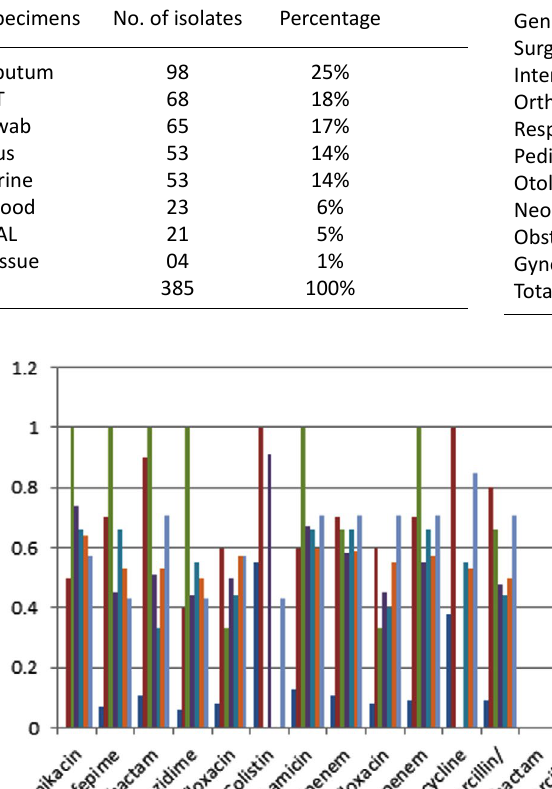
Table 1. Specimen wise distribution of isolates (n=385) Specimens